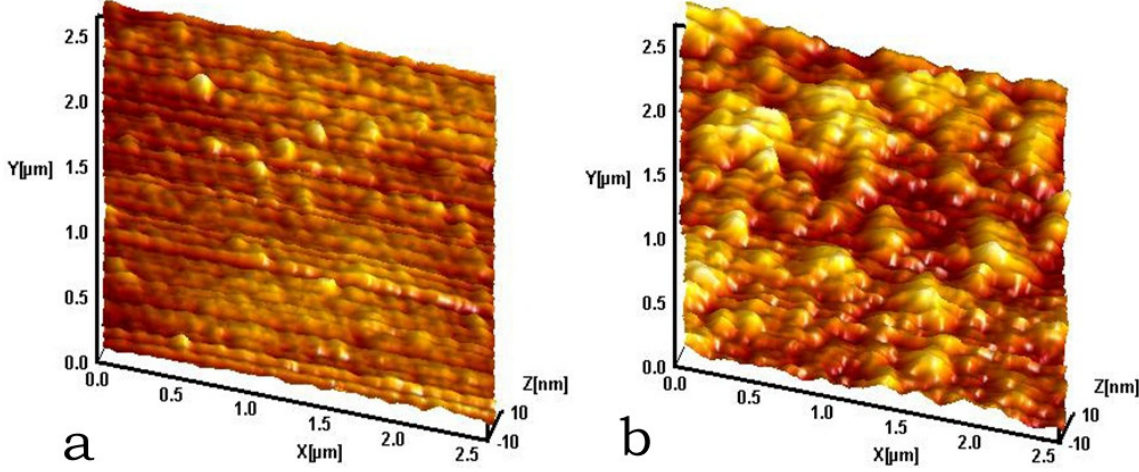
thin films: ( a ) TiO 2